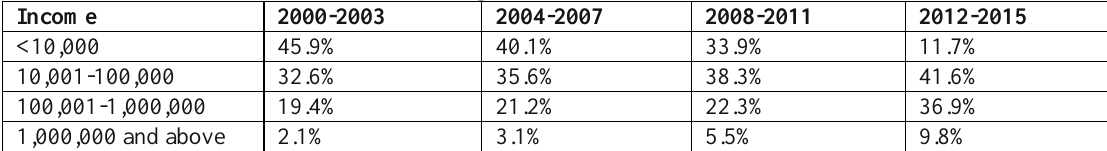
Table 5: Percentage Growth in Farmers’ Incomes